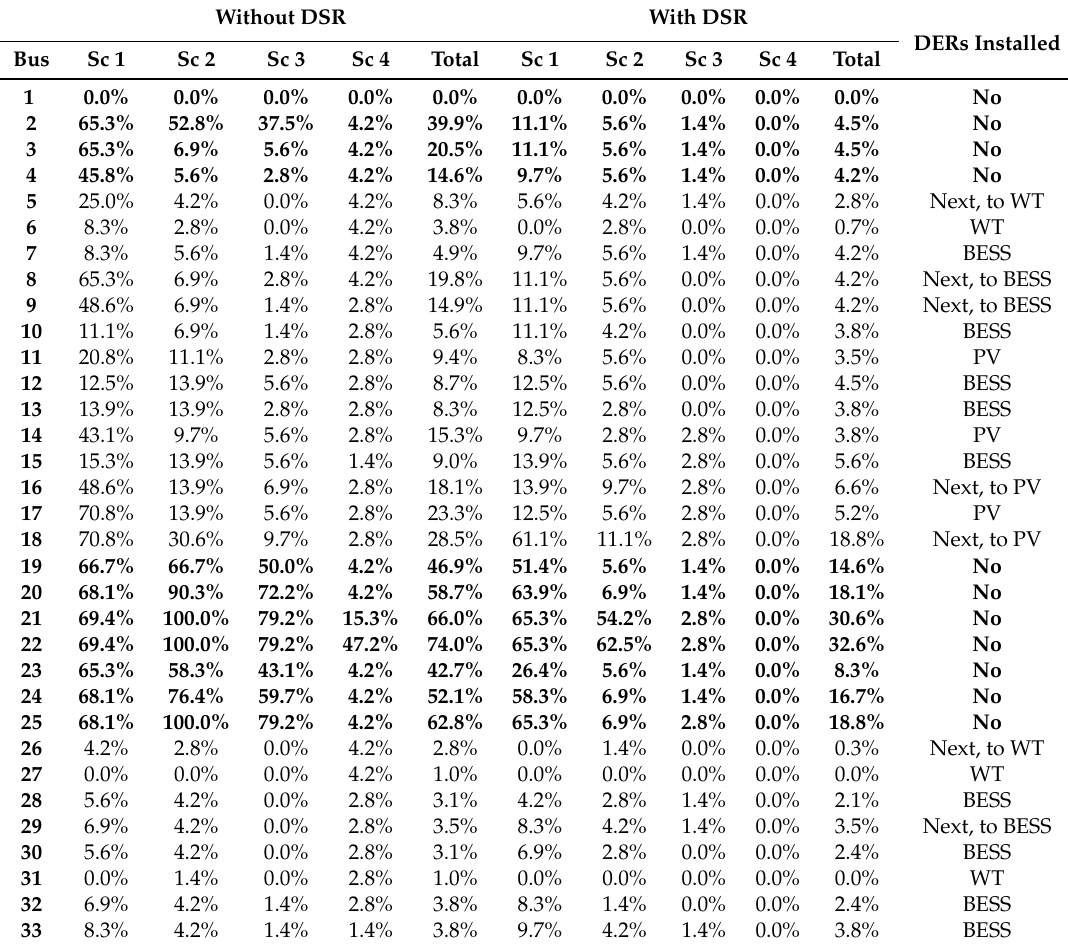
Table 2. Probability that a bus has energy not